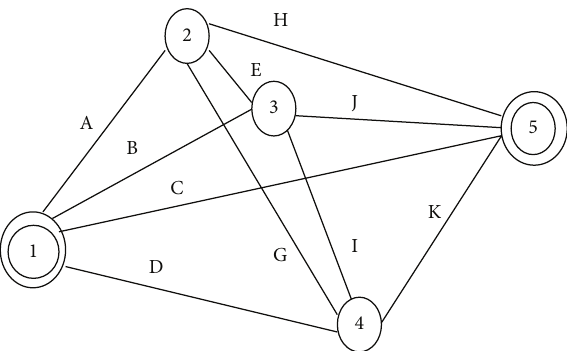
Figure 4: Input graph 𝐺(𝑉,𝐸) with source vertex = 1 and destination vertex = 5.